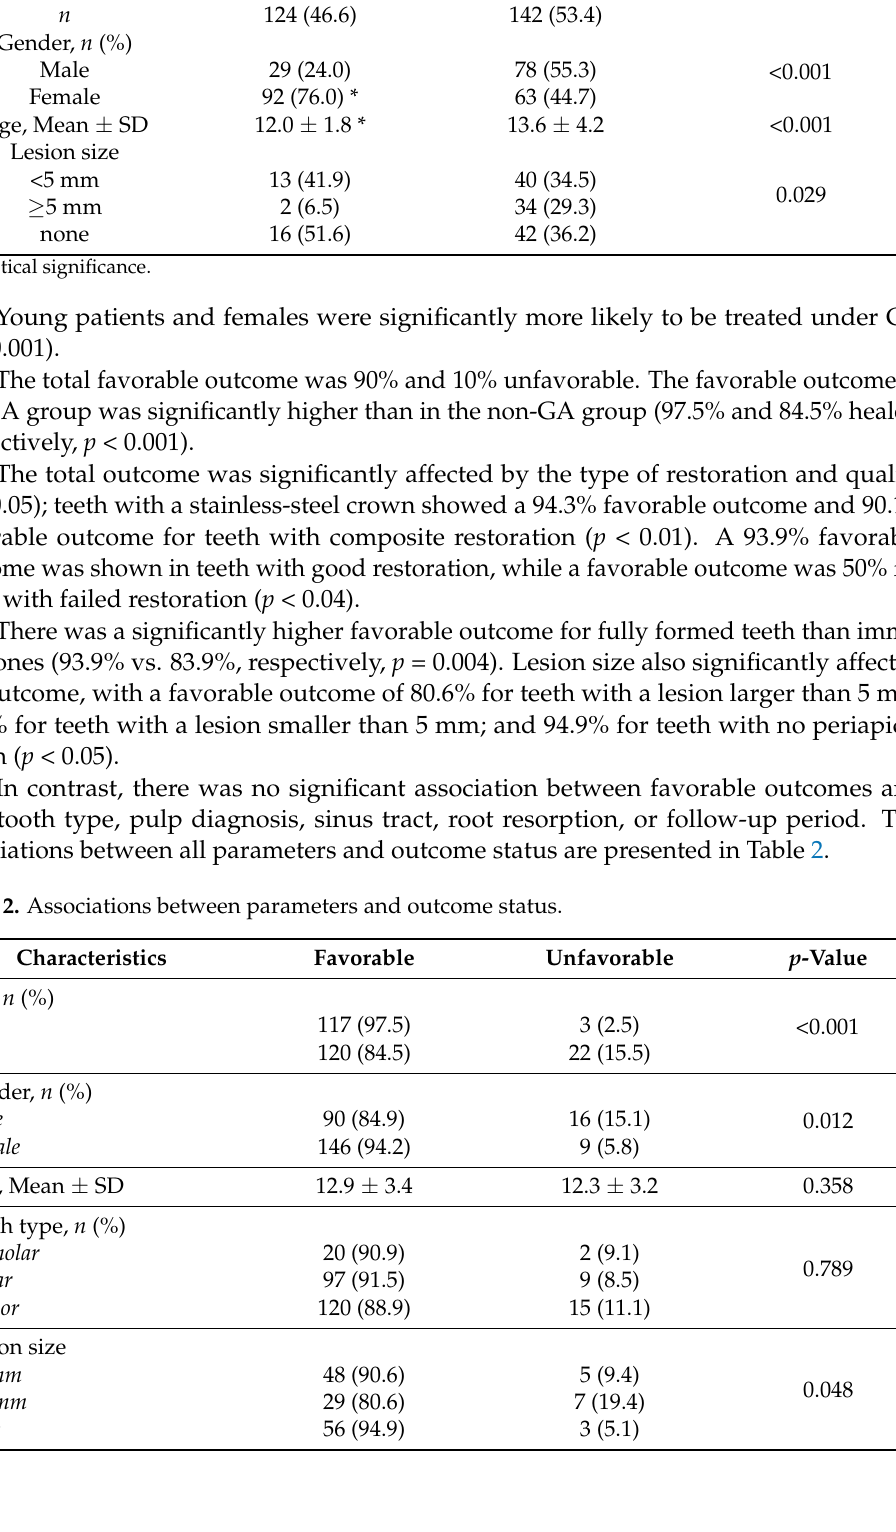
Table 1. Associations between preoperative parameters and GA. Characteristics